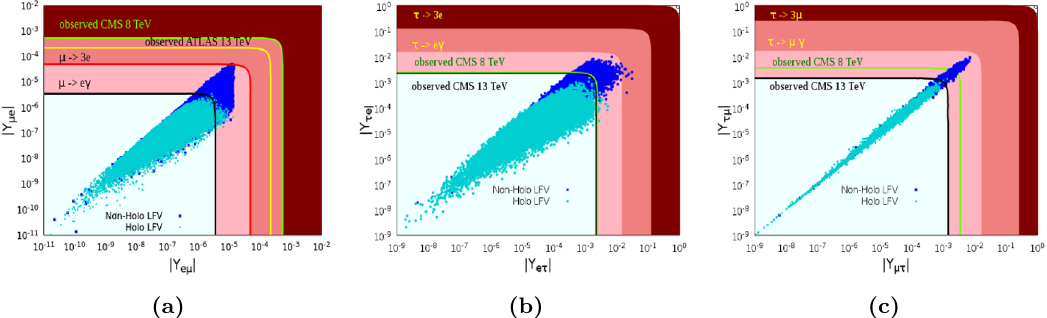
Y ij and Y ji from CMS results j j j j